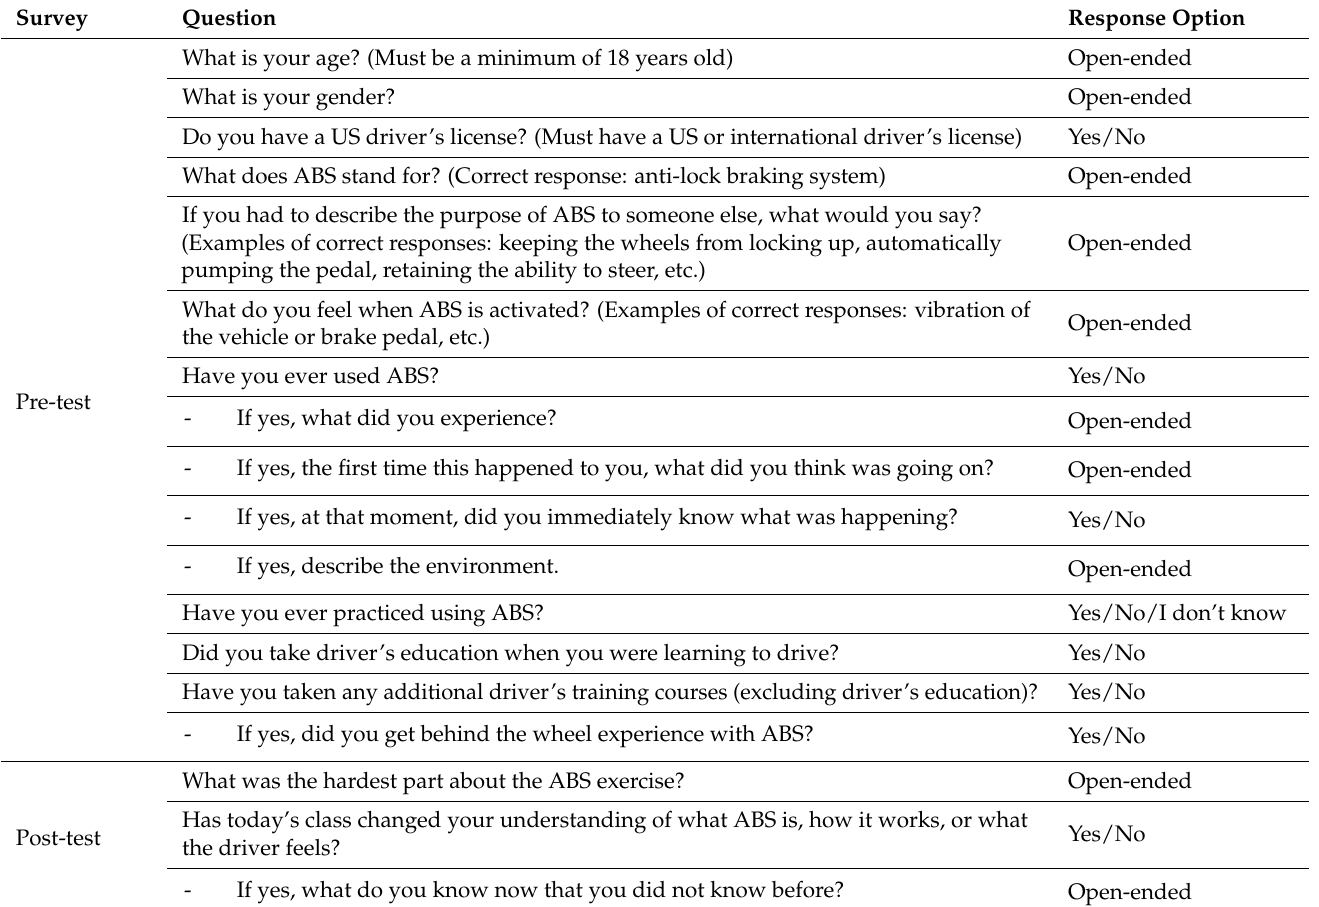
Table 1. Pre- and post-test survey questions. Items in parentheses are requirements to participate in the study and/or examples of correct responses.